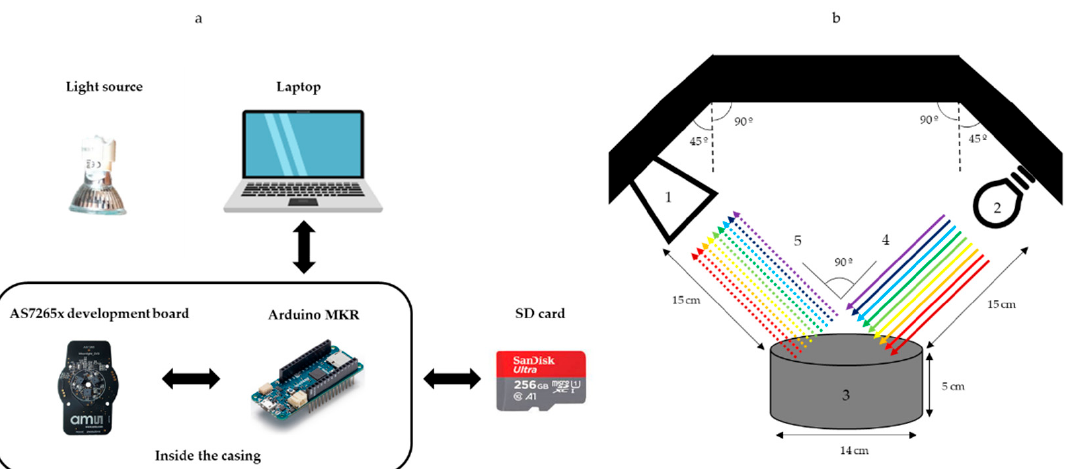
Figure 1. ( a ) Schematic of the components of the developed low-cost device based on a multispectral sensor. ( b ) Basic diagram of the developed device: (1) spectral detector, (2) light source, (3) sample, (4) incident light, and (5) reflected light.